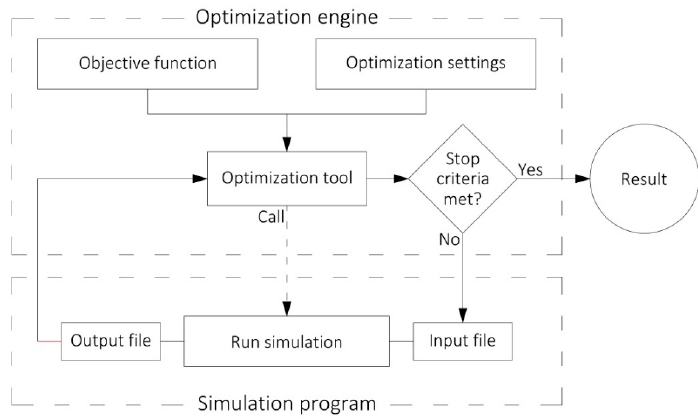
Figure 2. Coupling of a simulation program and an optimization engine in a simulation-based optimization method.